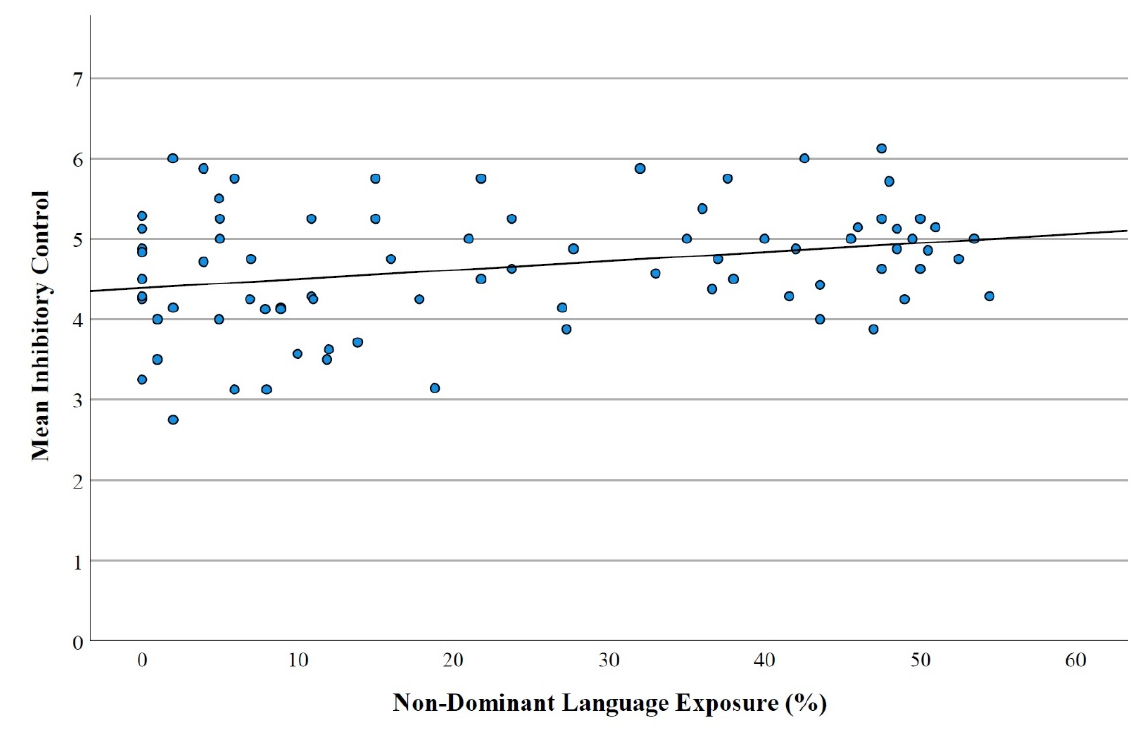
Figure 2. Regression plot of inhibitory control score by non-dominant language exposure.